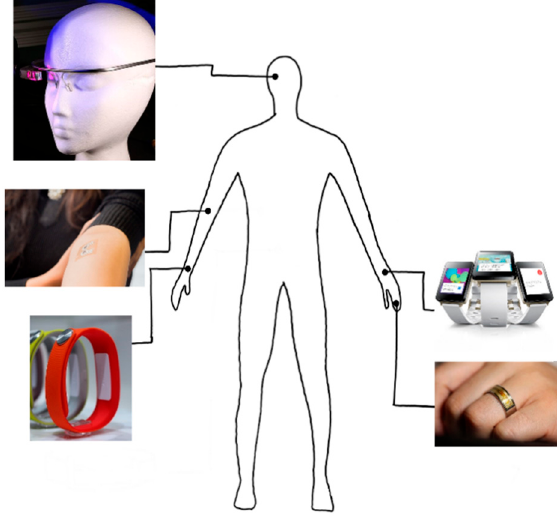
Figure 14. Wearable sensors.